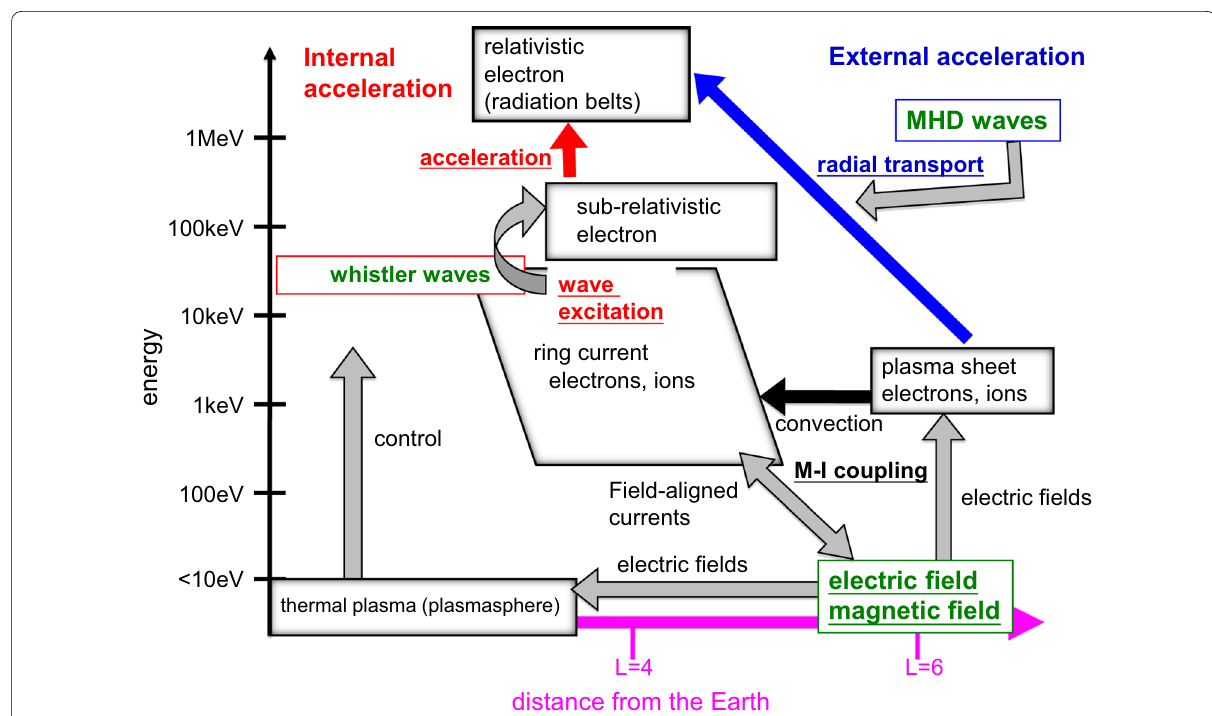
Fig. 1 Diagram of cross‑energy coupling processes in the inner magnetosphere (modified from Miyoshi et al.